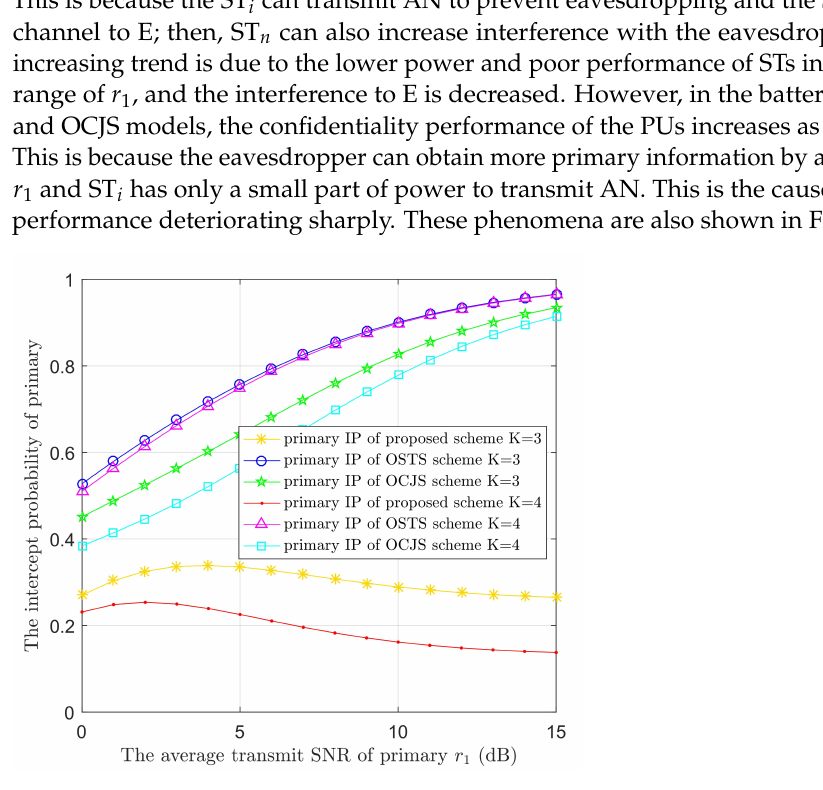
Figure 4. The IPs of the PUs versus the average transmit SNR of primary ( r 1 ) in the three protocols with different numbers of STs ( K